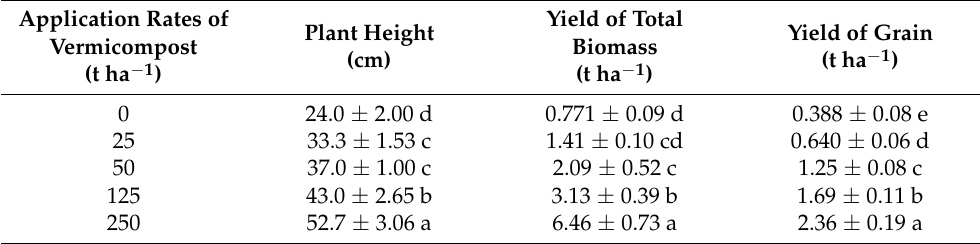
Table 3. Effects of vermicompost application on the height, total biomass yield, and barley plant grain grown in mudflat salt-affected